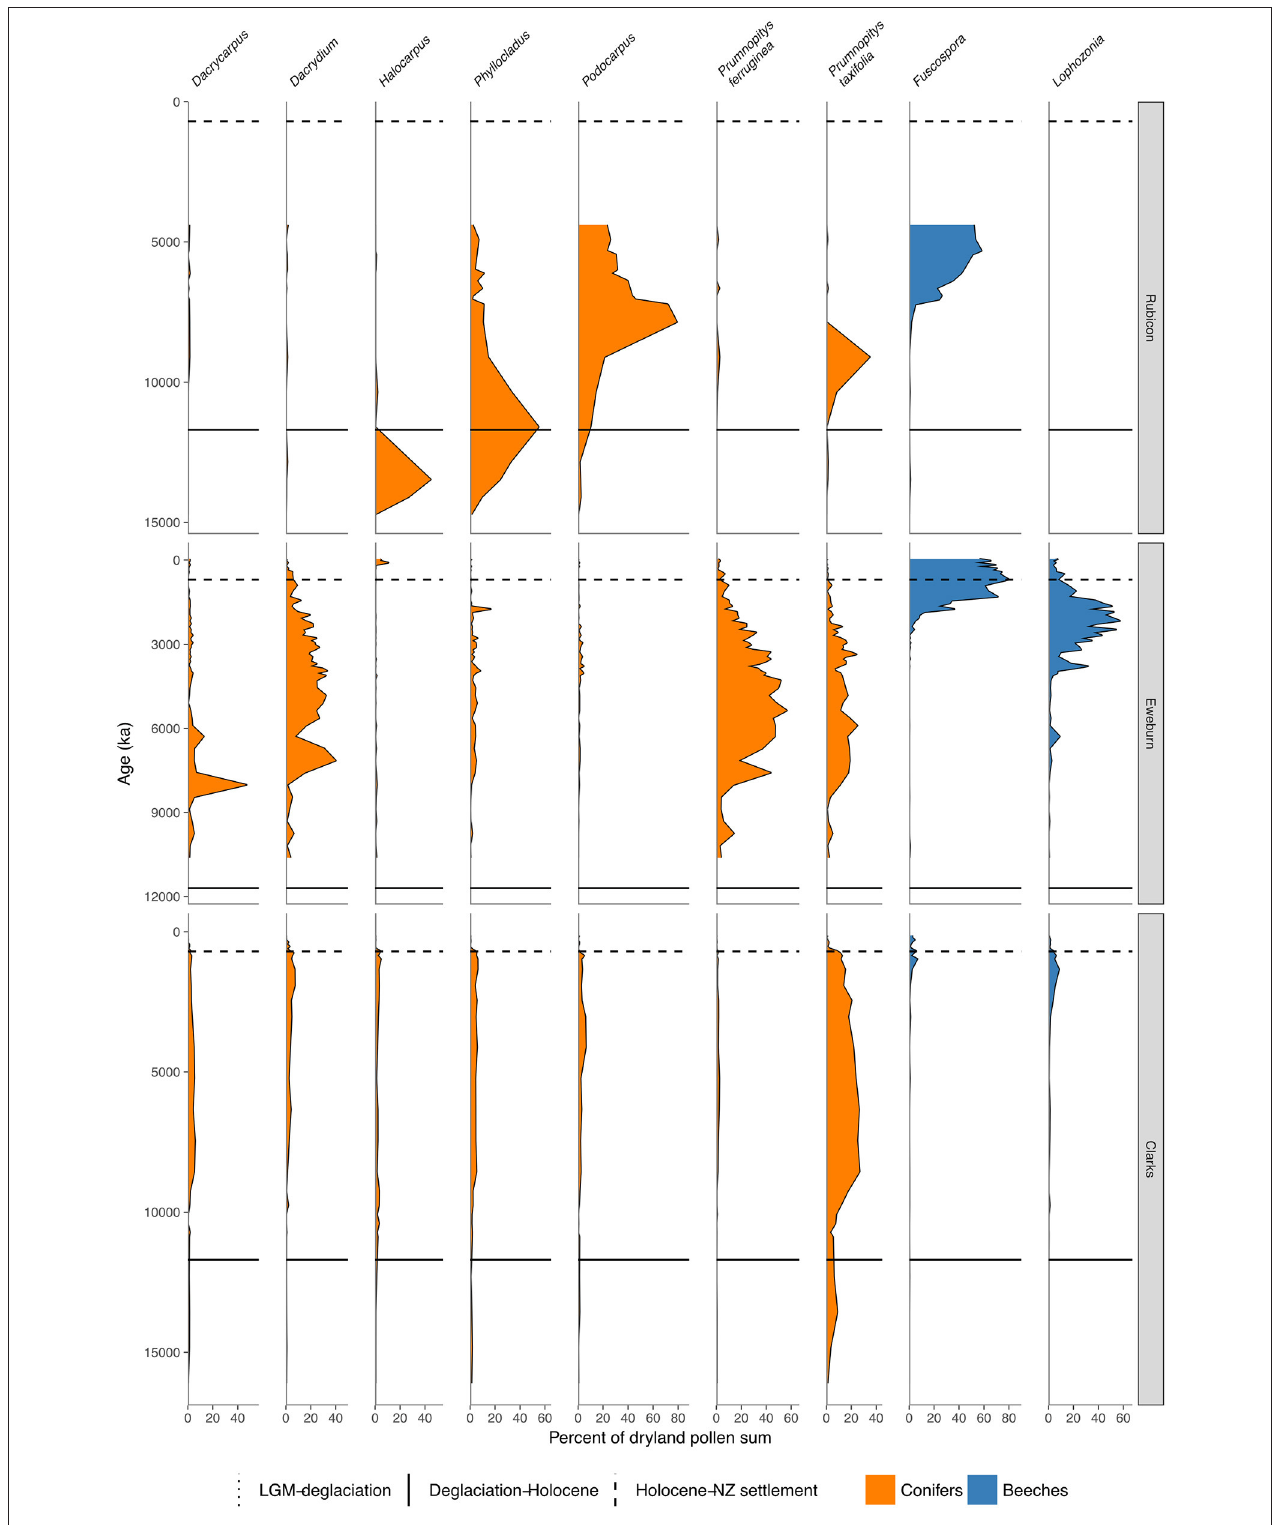
FIGURE 8 | Conifer and Nothofagaceae pollen sequences (cont.). Rubicon River, inland Canterbury (Moar, 1973). Eweburn Bog, Southland (Wilmshurst et al., 2002). Clarks Junction, Otago (McGlone et al., 2003).